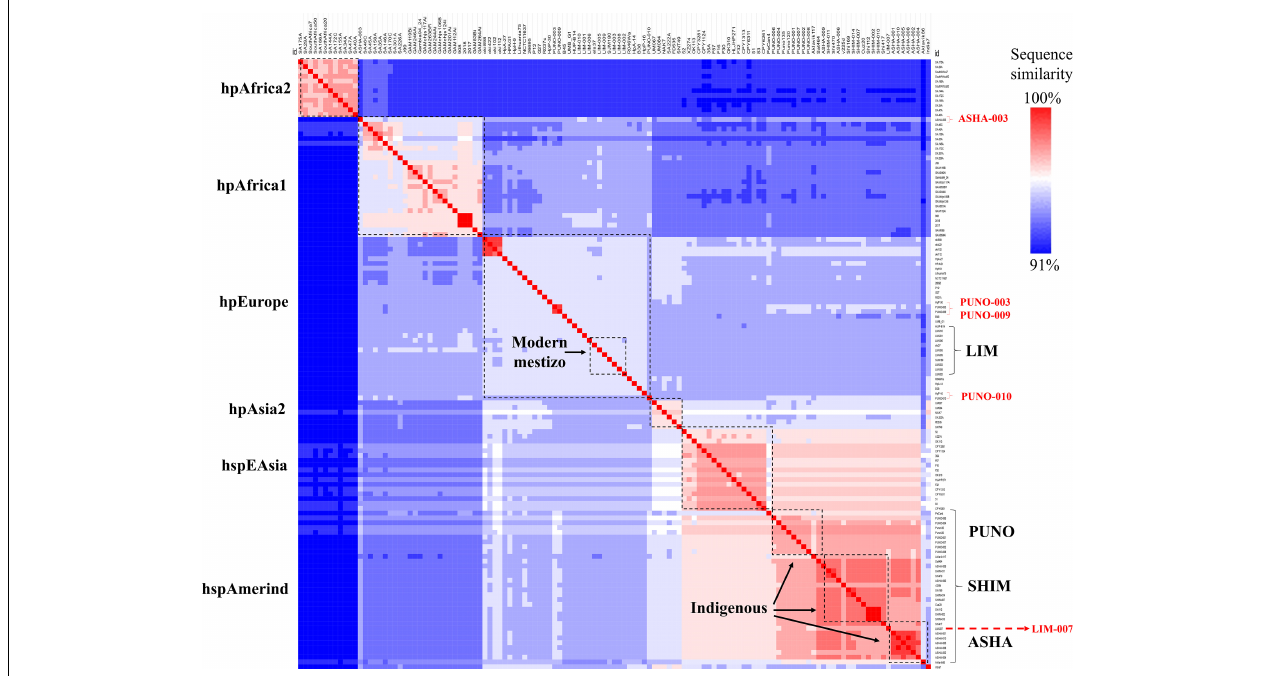
FIGURE 1 | Hierarchical clustering analysis of ANIb values. Each line represents the similarity score of each H. pylori genome (32 study and 95 references). Left, ancestral H. pylori populations. Right, H. pylori study populations. Heavily admixed genomes (ASHA-003, PUNO-003, PUNO-009, PUNO-010, and LIM-007) are shown in red